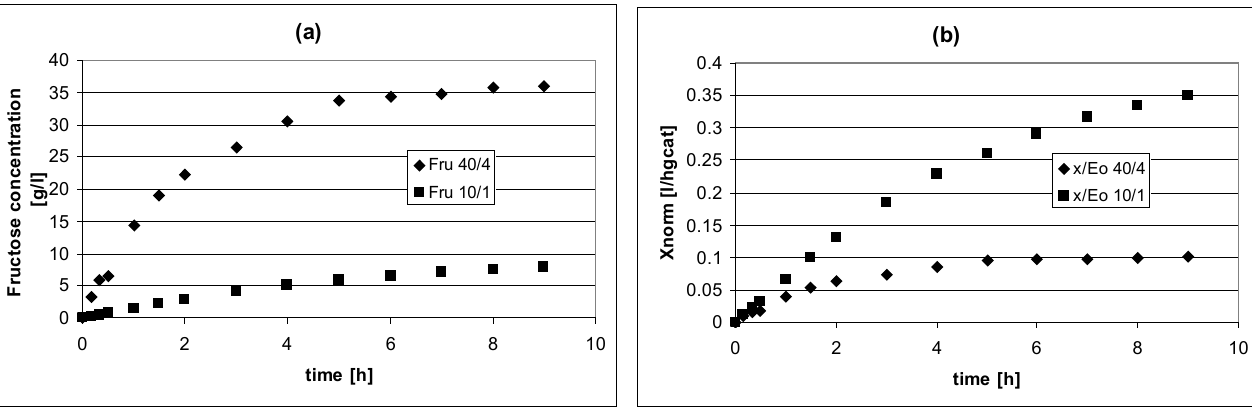
/E = 10/1 (rhombi) and S 0 0